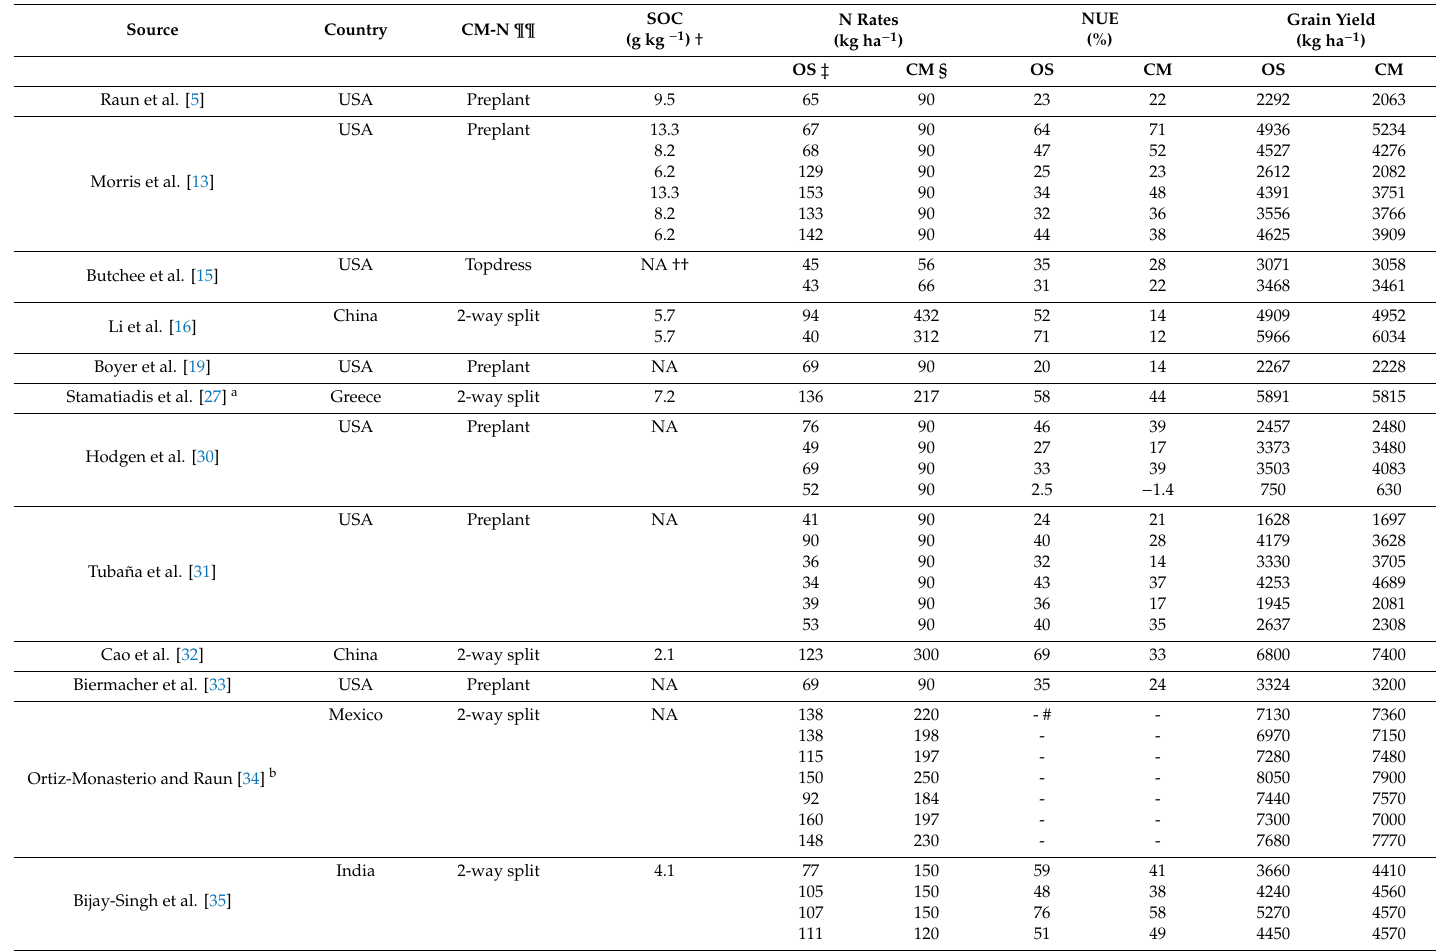
Table 1. Peer-reviewed research articles used to compute NUE and grain yield at selected N rates using active optical sensors and conventional methods of N